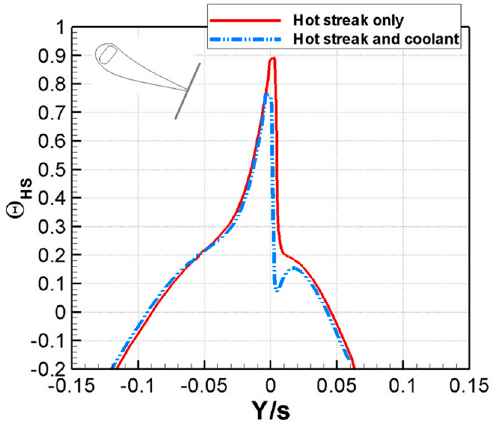
Figure 11. Predicted midspan temperature ratio ( Θ HS ) at the trailing edge, for the hot streak aligned with the vane.